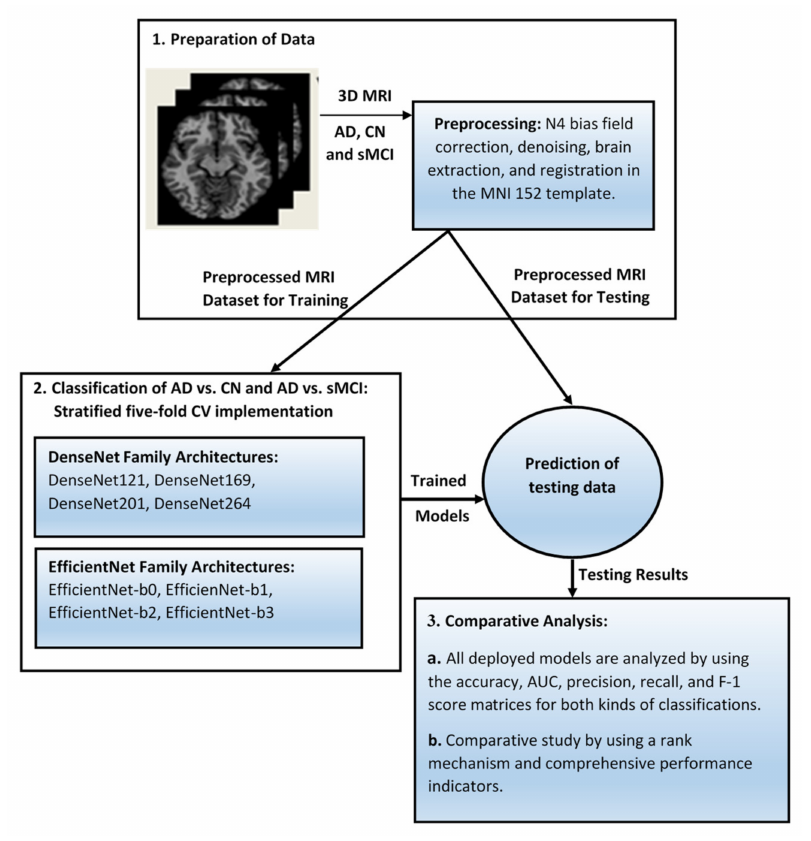
Figure 1. The proposed method’s overall architecture. Table 1. Factors to consider while analyzing ADNIMERGE file.